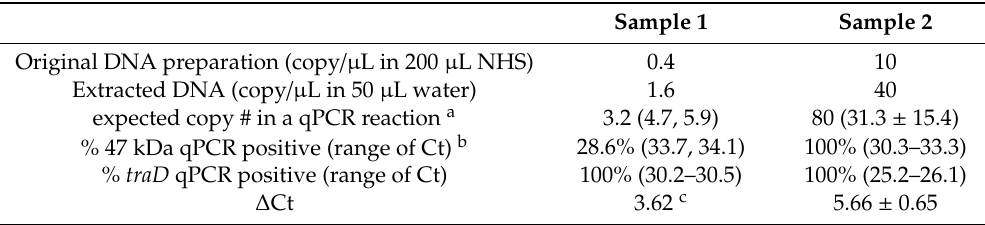
Table 2. Superior sensitivity of traD qPCR was demonstrated using purified genomic DNA spiked in normal human plasma